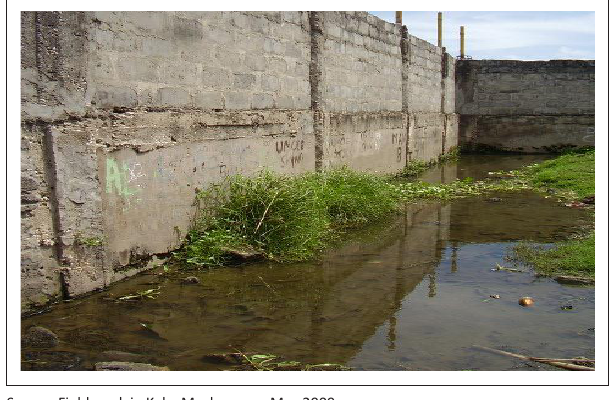
Source : Field work in Keko Machungwa, May 2009 FIGURE 3: Wall constructed by Ruby Road Ways on top of the stream, blocking the natural course of the river.